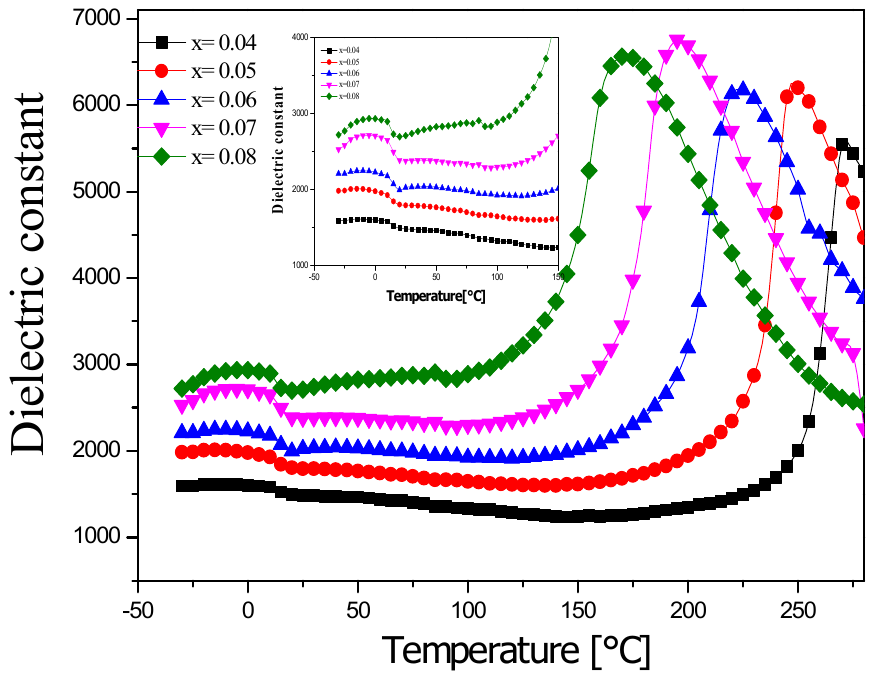
Figure 10. Temperature dependence of dielectric constant with the amount of antimony. Table 1. Electrical properties of samples with the amount of antimony . Sinter.